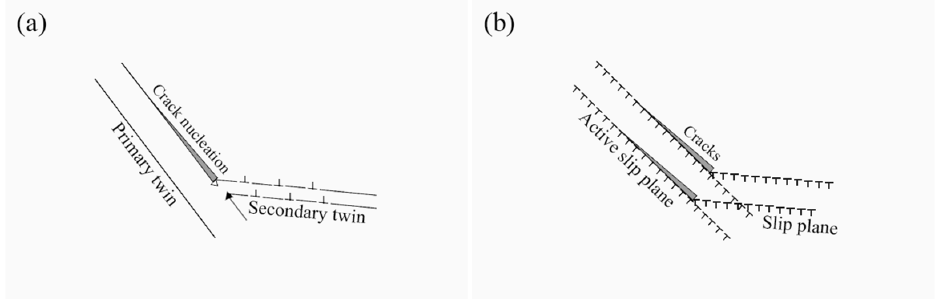
Figure 6. The schematic diagram of cracks nucleated by crossed deformation twin ( a ) and double slip of dislocations ( b ).